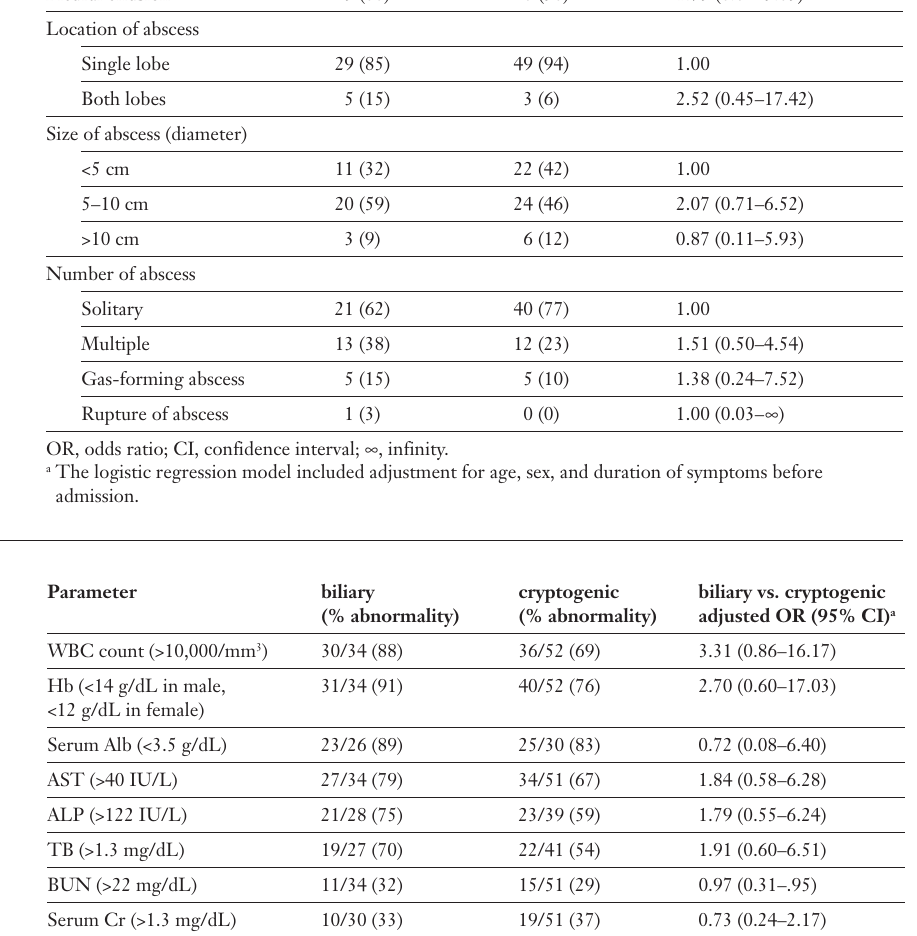
Imaging findings on admission in the biliary and cryp- togenic groups.